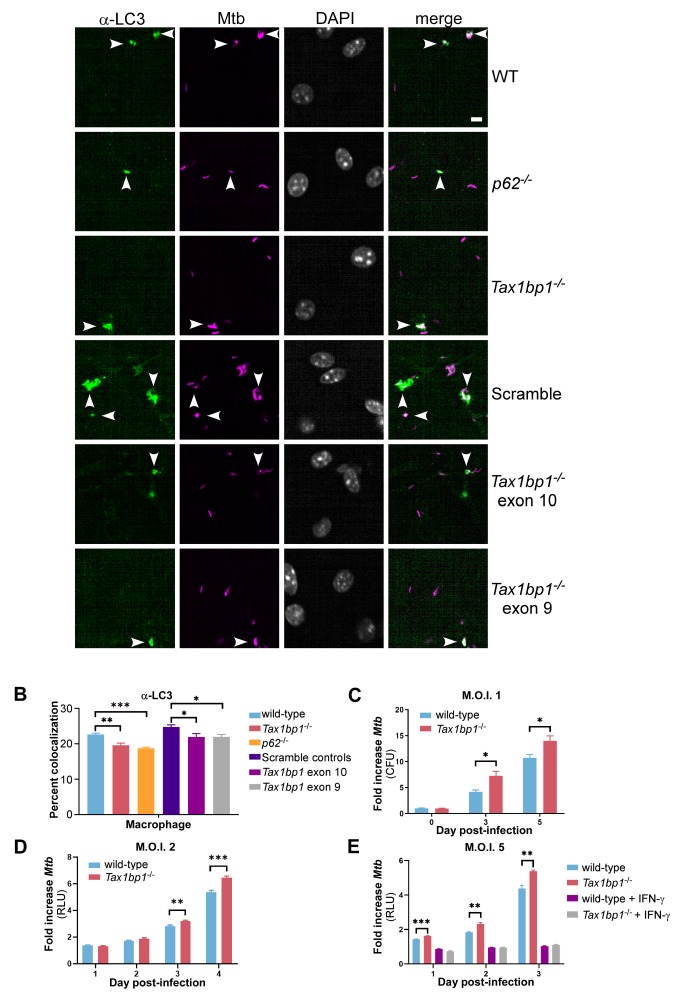
TAX1BP1 deficiency abrogates targeting of Mtb to LC3 and enhances the growth of Mtb in macrophages ex vivo.(A) Fluorescence images of bone-marrow-derived macrophages infected with mCherry-expressing Mtb (magenta) and immunostained with α-LC3 antisera (green). Nuclei were stained with DAPI (white). White bar denotes 10 µm. (B) Quantitative analysis of Mtb colocalization with LC3 at 8 hr post-infection. Results are the means ± SEM for four technical replicates of a single experiment representative of two independent experiments. * p value less than 0.05 by t-test. ** p value less than 0.01. *** p value less than 0.001. (C) Bone-marrow-derived macrophages infected with Mtb at a multiplicity of infection of 1 were enumerated for CFU at days 0, 3, and 5 post-infection. Fold change in CFUs is displayed. Results are the means ± SEM of three technical replicates. (D and E) Luminescence from macrophages infected with Mtb harboring luxBCADE at a multiplicity of infection of 2 (D) or 5 (E) was measured daily. Fold change in relative light units (RLUs) is displayed. * p value less than 0.05 by t-test. ** p value less than 0.01. *** p value less than 0.001. Results are the means ± SEM of five technical replicates of two independent experiments.